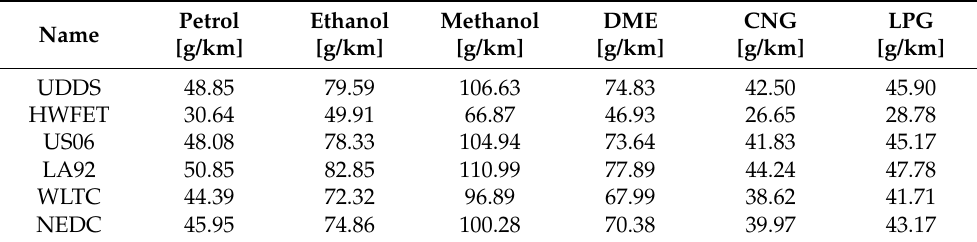
Table 7. Summary of the final consumption of tested fuels per kilometer travelled obtained from simulations of the 2018 Toyota Camry LE vehicle for selected road tests.